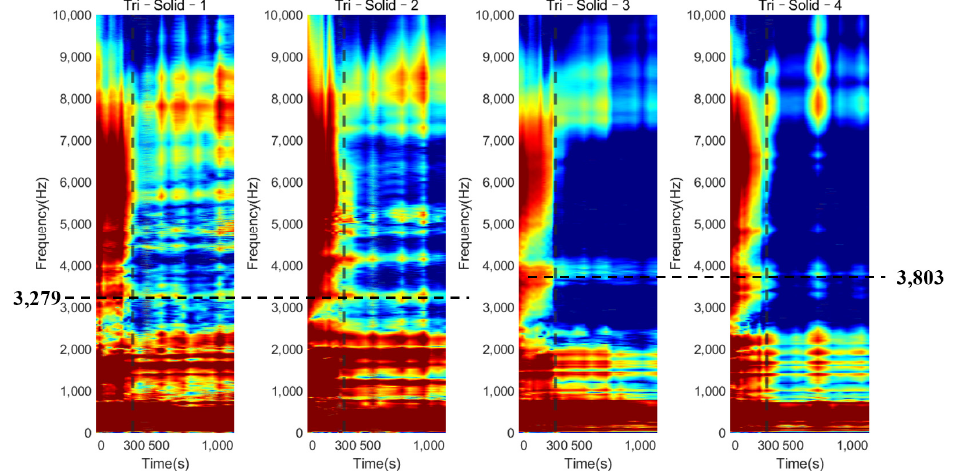
Figure 8. Plots of the normalized magnitude development as the function of cure time for triangular implants with a solid IM stem.